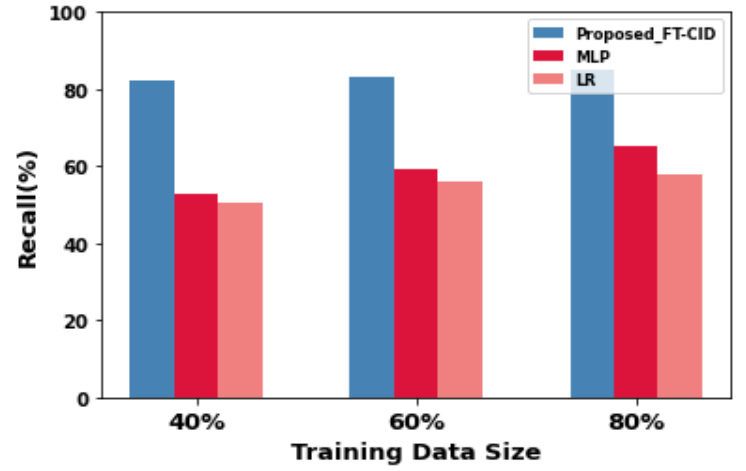
Figure 5. Recall performance for FT-CID, MLP, and LR. Table 2. Comparative experimental recall results.